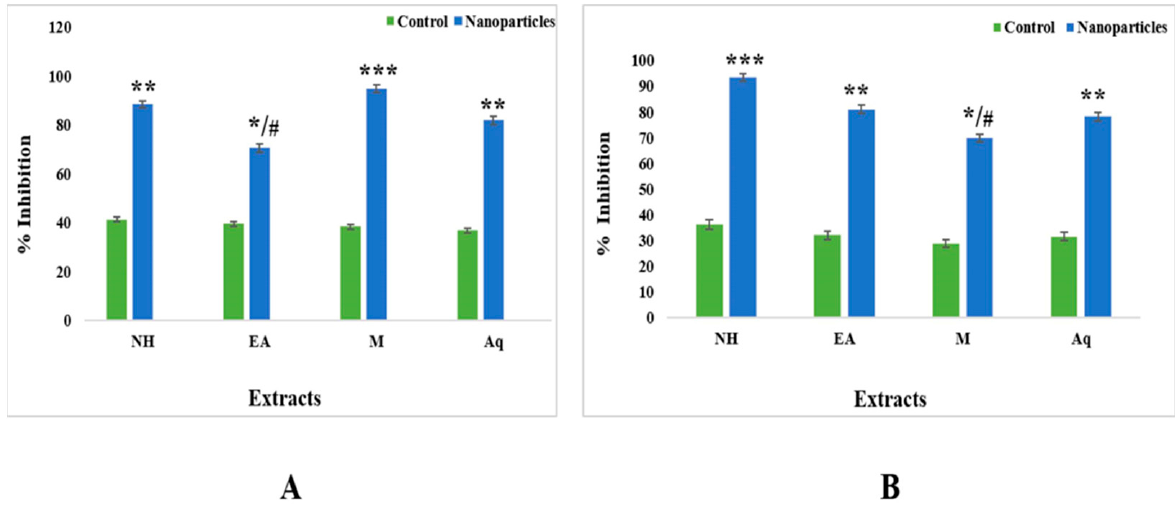
Figure 12. Alpha-amylase inhibition of nanoparticles and control from leaves of C. colocynthis: ( A ) fruits; ( B ) leaves. Data are expressed as the mean ± SD. */# p < 0.05, ** p < 0.01 *** p < 0.001. Leaf control fractions range from 41.41% for the n-hexane extract, 39.5% for the ethyl acetate extract, 38.41% for the methanol extract, and 36.79% for the aqueous extract. For nanoparticles, the n-hexane extract showed 91.3% inhibition, the ethyl acetate extract showed 79.41% inhibition, the aqueous extract showed 79.5% inhibition, and the methanol extract showed 69.7% inhibition (Figure